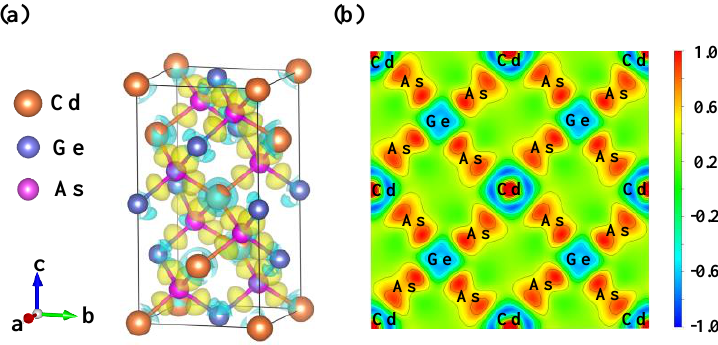
Figure 4. The differential charge density of CdGeAs 2 . ( a ) 3D, ( b ) 2D.